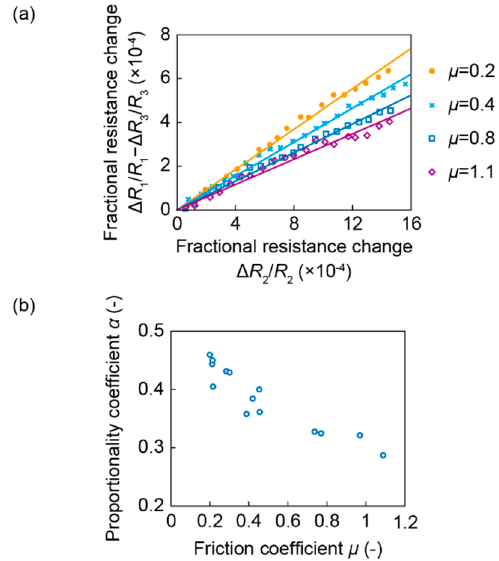
Figure 9. ( a ) Relationship between two fractional resistance changes, Δ R 2 / R 2 and Δ R 1 / R 1 — Δ R 3 / R 3 ; ( b ) Relationship between the proportional coefficient α and the friction coefficient μ .